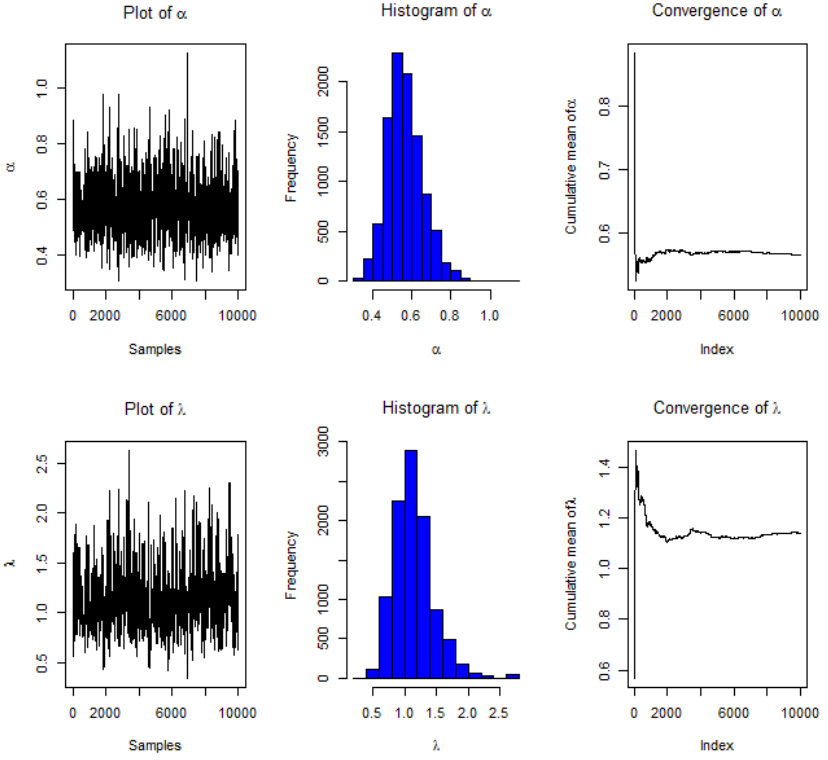
Figure 3. Plots of convergence of MCMC estimates for α and λ by using MH algorithm under PT1C10 and CT − IV where m = 4 and n =